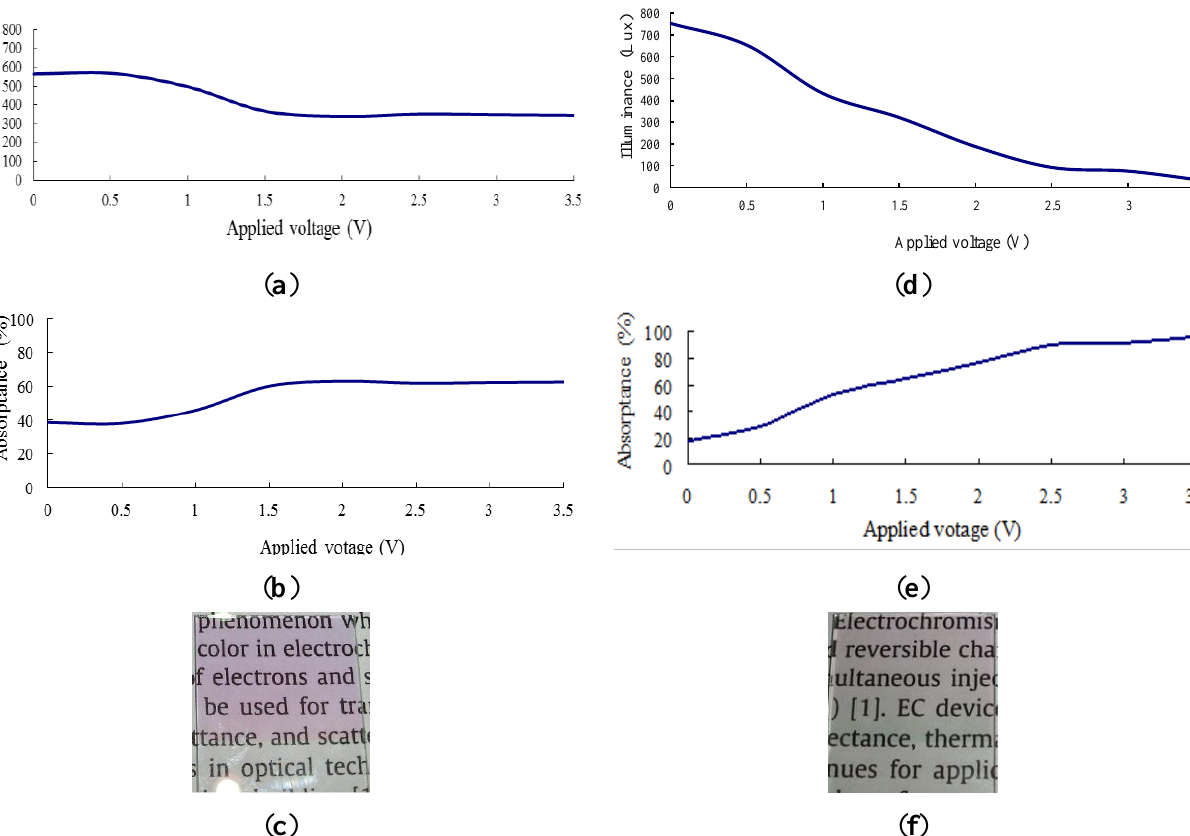
Figure 6. Transmittance and absorptance properties of ITO/WO